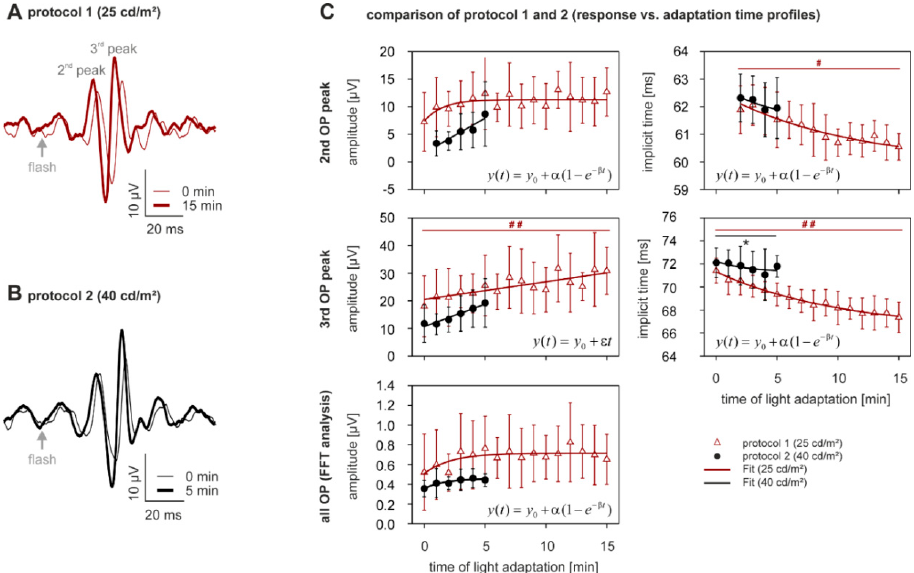
Figure 2. Light adaptation—OP analysis. ( A , B ) for subject averaged OPs in the same format as Figure 4. Subject averaged ( C ) amplitudes for the second and third OP waves and for the general OP in the frequency domain vs. time of photopic adaptation (same format as in Figure 4). n 25 cd/m2 = 10, n 40 cd/m2 = 9.